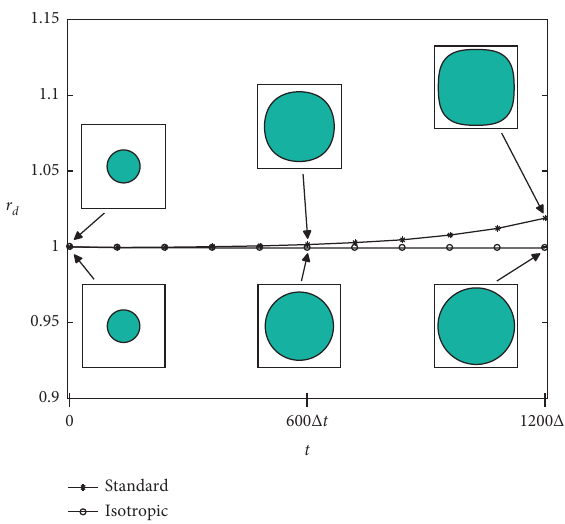
Figure 3: Plot of r d among standard and isotropic schemes.